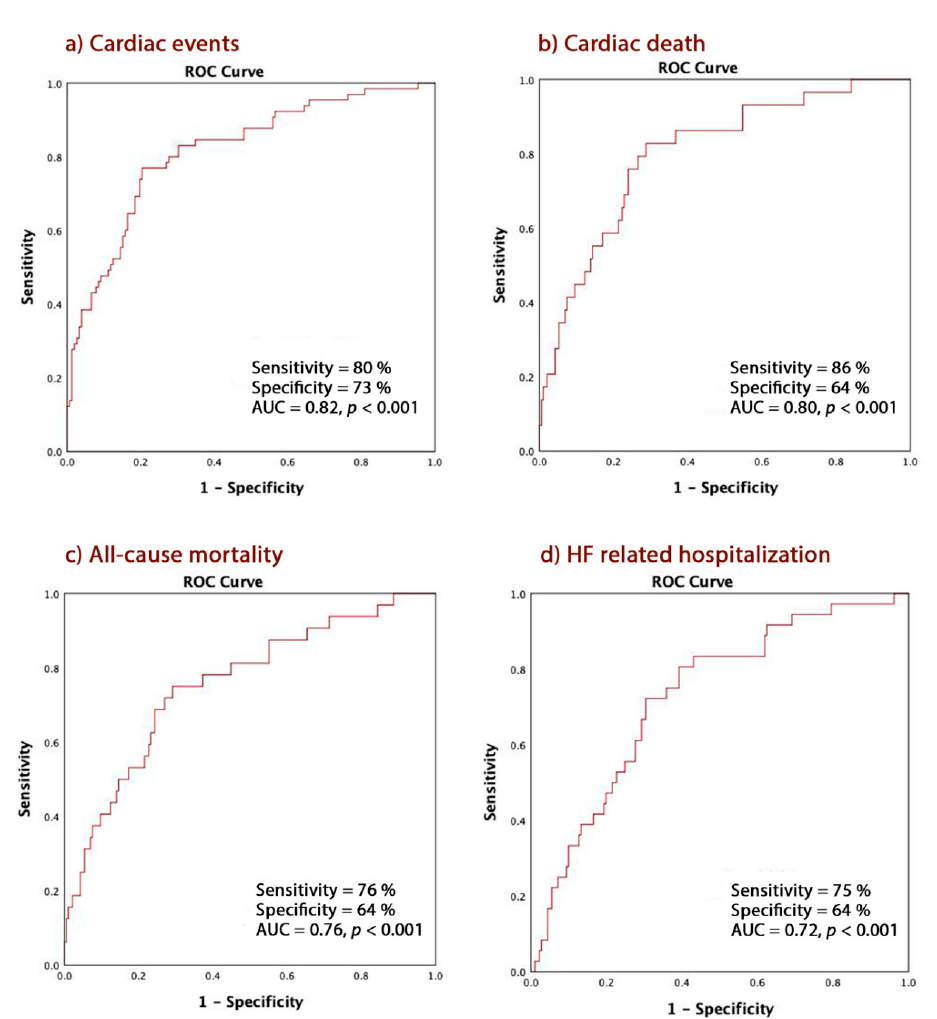
Figure 1. LA stiffness ≥ 0.76% in predicting. ( a ) Cardiac events; ( b ) Cardiac death; ( c ) All-cause mortality; ( d ) HF-related hospitalization. HF: heart failure; AUC: area under curve; ROC: receiver operator characteristic.